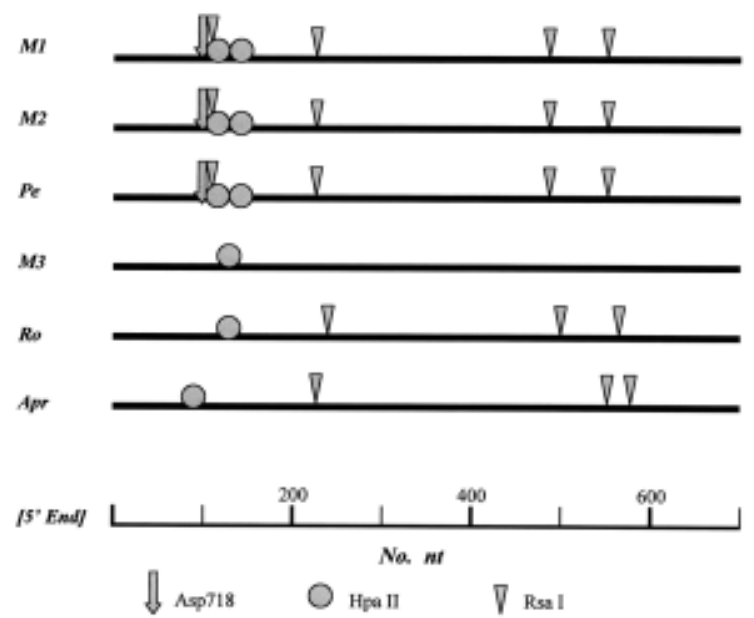
Fig. 2. Restriction map of the PCR products of Prunus necrotic ringspot virus isolates; M1, M2, Pe, M3, Ro and Apr. No. nt : number of nucleotides.